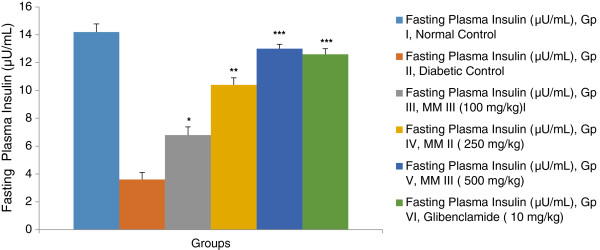
Effect of Melastoma malabathricum Linn. (MM) on level of plasma insulin at different concentrations on STZ induced diabetic rats, compared to standard drug Glibenclamide; values are mean ± SEM; n = 6; *P < 0.05; **P < 0.01; ***P < 0.001; P > 0.05 is considered as non-significant (ns).